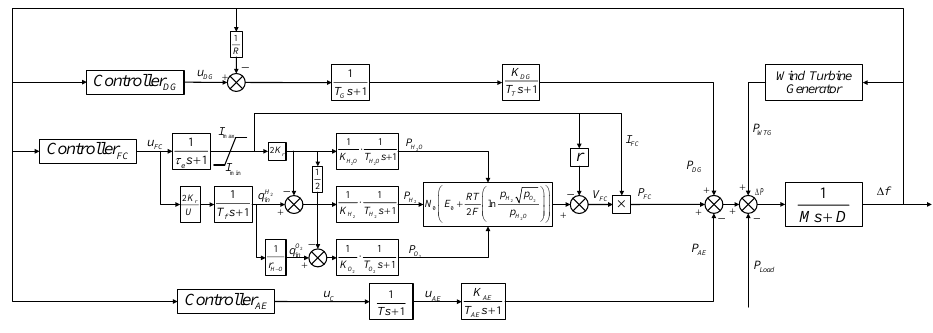
Figure 8. Microgrid power system control